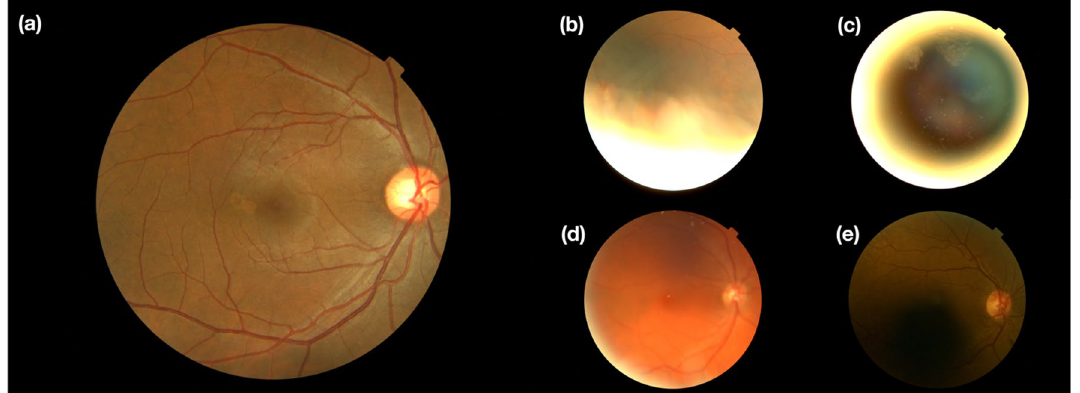
Figure 4. Demonstration of selected images. ( a ) Ideal image quality. ( b ) Insufficient image quality with artifacts. ( c ) Insufficient image quality with bad composition. ( d ) Insufficient image quality due to being out-of- focus. ( e ) Insufficient image quality with unbalanced and insufficient illumination.